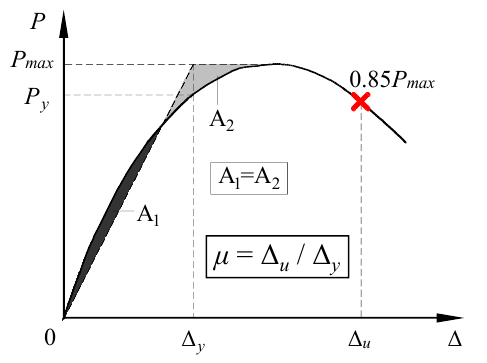
Figure 8. Maximum lateral strength.